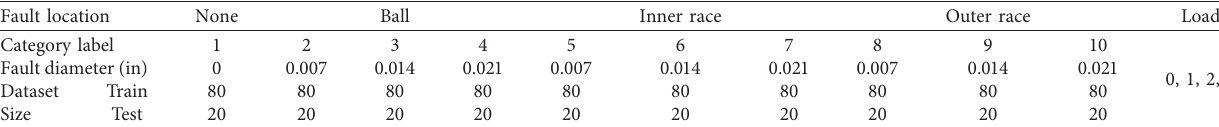
Figure 5: The faults of bearing in three locations: (a) inner fault; (b) outer fault; (c) ball fault. Table 1: Description of rolling element bearing